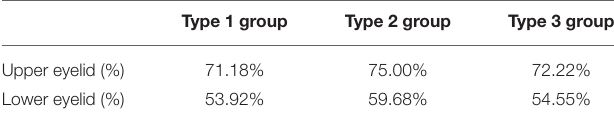
TABLE 5 | Percentage of eyes with more than 1/3 meibomian gland dropout (Meiboscores of 2 and 3) in three groups after case-control